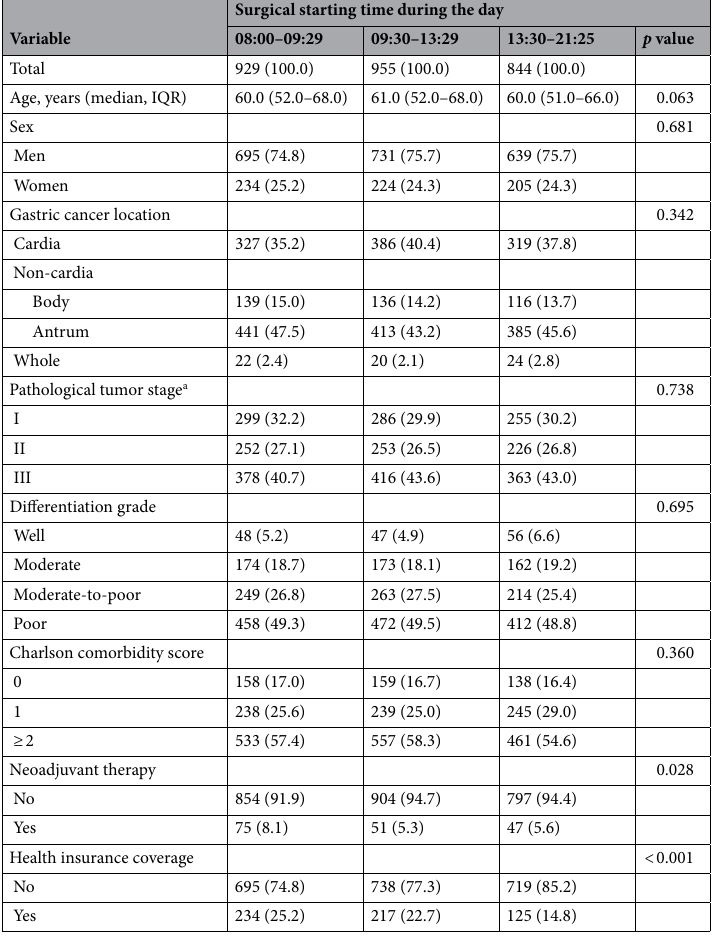
Table 1. Characteristics of 2728 patients who underwent gastrectomy for gastric cancer, number (%). IQR interquartile range. a Pathological tumor stage according to the American Joint Committee on Cancer TNM staging system, 7th